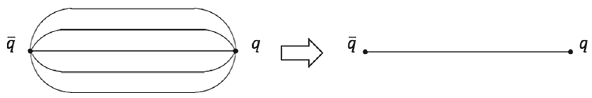
Fig. 1 A simplified colour-field topology in a q ¯ q system and its further simplified string